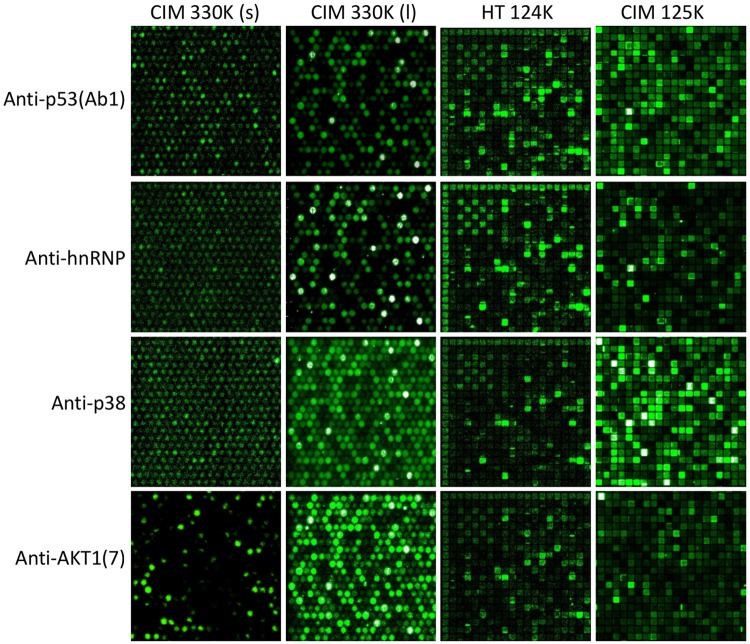
Raw images of a small portion of the upper-left portion of four different peptide microarrays showing four different monoclonal antibodies.The X axis is four different peptide libraries; CIM330K (short) is a library of 330,000 random-sequence peptides of length 12.2 residues; CIM 330K (long) is a library of 330,000 random-sequence peptides of length 17 residues. HT124K is a library of 124,000 random-sequence peptides of length 9 residues; CIM125K is a library of 125,000 peptides of mean length 12 residues. The Y axis is four commercially-sourced monoclonal antibodies. Row 1: anti-human TP-53 (Ab1) has low binding to most peptides but very high binding to a small subset of peptides, especially to those containing the sequence RHSVV. Row 2: anti-human hnRNP monoclonal has an intermediate binding prevalence, with approximately 15% of the total peptides binding at >2SD above background. Row 3: anti-human p38 monoclonal has low binding pattern but at least 15% of all peptides bind at least 2SD above background with a few high binders. Row 4: anti-AKT1(7) monoclonal has more promiscuous binding with >40% of all peptides binding >2SD above background for HT124K and CIM125K. This visual display is intended to demonstrate qualitatively how diverse the binding patterns are.